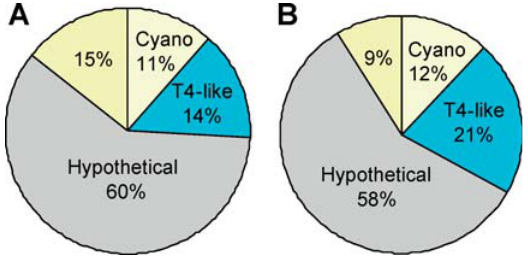
Figure 5. Taxonomy of Best BLASTp Hits for P-SSM2 and P-SSM4 Each predicted coding sequence from both phage genomes was used as a query against the nonredundant database to identify the taxon of the best hit (details in Materials and Methods). Blue slices indicate phage hits, while yellow slices indicate cellular hits. DOI: